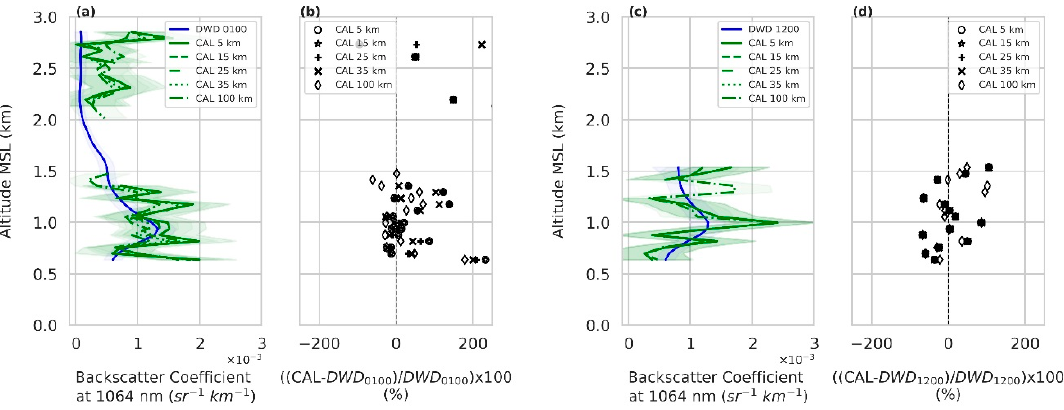
Figure 7. Backscatter Coefficient at 1064 nm profiles and the corresponding mean percentage difference as a function of altitude m.s.l for a CALIOP overpass at Harzgerode on ( a , b ) 6 August 2014 (cloud–free case) at 01:39:59 UTC at 33.55 km distance from Harzgerode and ( c , d ) 4 May 2016 (case with a thin cloud) at 12:20:44 UTC at 43.65 km distance from Harzgerode–DWD. The comparison uses CALIOP 5 km, 15 km, 25 km, 35 km and 100 km along–track averages(1, 3, 5, 7 and 20 vertical profiles) and Harzgerode’s single vertical profile related to CALIOP’s closest passage time at nighttime (0100) and daytime (1200). The shaded areas represent the standard deviation of the measurements. Overall, the agreement between CALIOP and the ground–based ceilometer is good in terms of profile shape for both the cloud–free and the thin–cloud cases. For the cloud–free case, Figure 7a shows that the DWD ceilometer in Harzgerode was able to detect a full profile of backscatter coefficient up to approximately 3 km. In